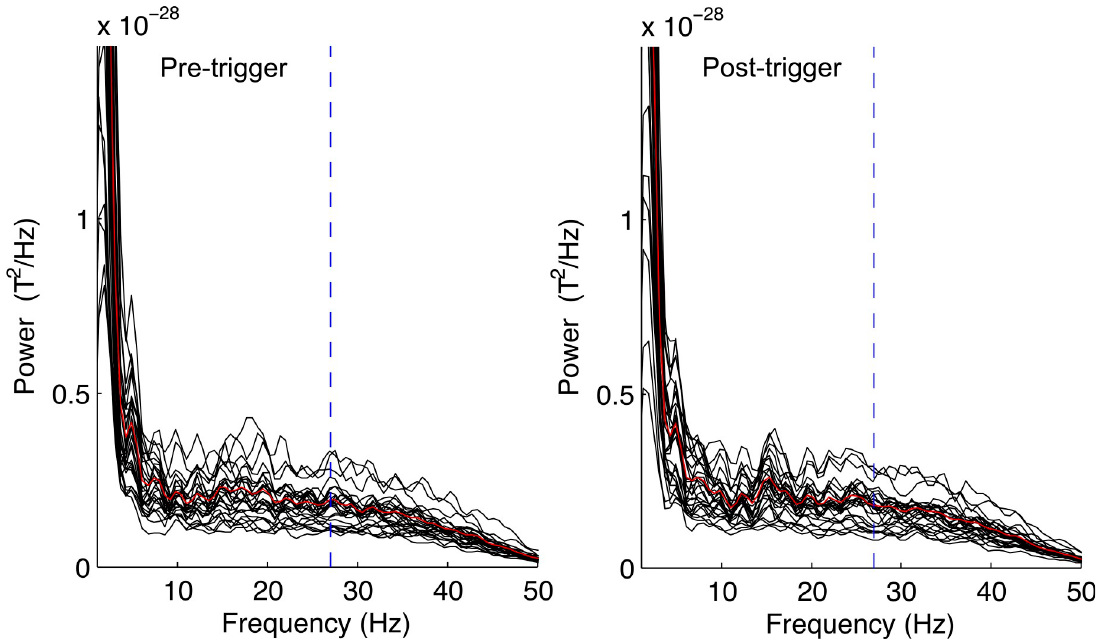
Fig 3. Power spectrum. Power spectrum of an exemplary recording at 35 weeks of gestation during stimulation (‘post-trigger’) and prior to stimulation (‘pre-trigger’). Calculation for all sensors within 10 cm of the head coil throughout all trials using a high pass filter of 1 Hz and a low pass filter of 50 Hz. Each black line represents an individual sensor, the red lines show the average. The MF at 27 Hz is marked by a blue, dashed